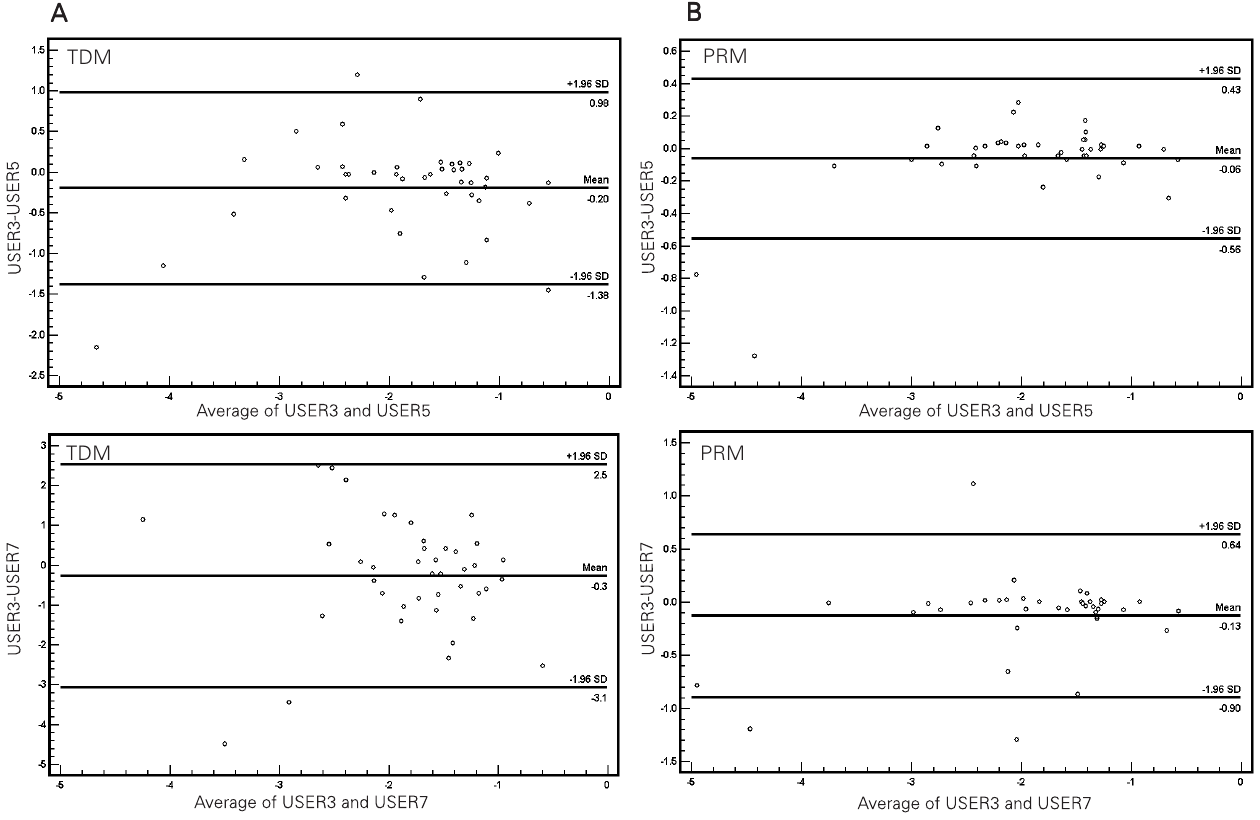
Figure 4. Bland and Altman plots for reflex bradycardia indexes after phenylephrine bolus infusions between USER3 and USER5, who had a common criterion for data collection and calculations for the TDM (A, upper panel) and the same users when using the PRM (B, upper panel). Comparison between USER3 and USER7, who had different criteria for data collection and calculations for the TDM (A, lower panel) and the same users when using the PRM (B, lower panel). Average values between users are presented on the abscissas and the ordinates show the differences between the two users against a mean difference (Mean, middle horizontal line). Upper (+1.96 SD) and lower (-1.96 SD) limits of agreement are shown as horizontal lines. Circles represent the differences between methods subtracted from a mean (Mean) difference. Note the greater agreement and narrower limits of agreement between users when the PRM is employed. TDM = traditional method; PRM = proposed